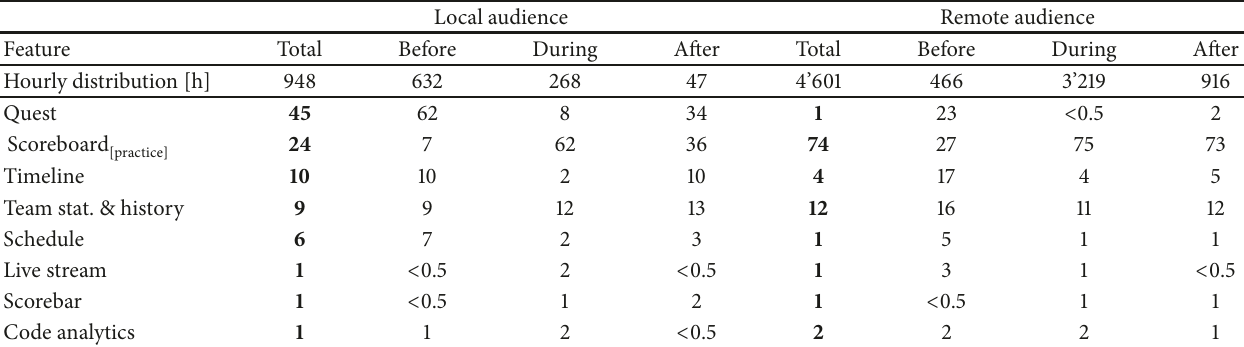
Table 5: Page visit time statistics [%].